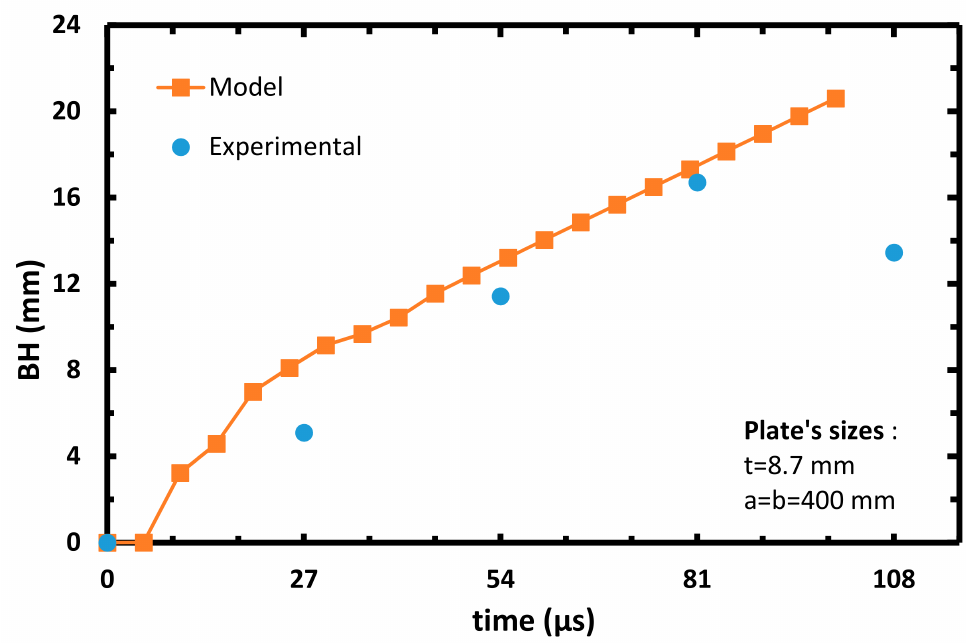
Figure 18. Plate’s bulge height vs. time of the calibrated model, Vinitial = 708 m/s.